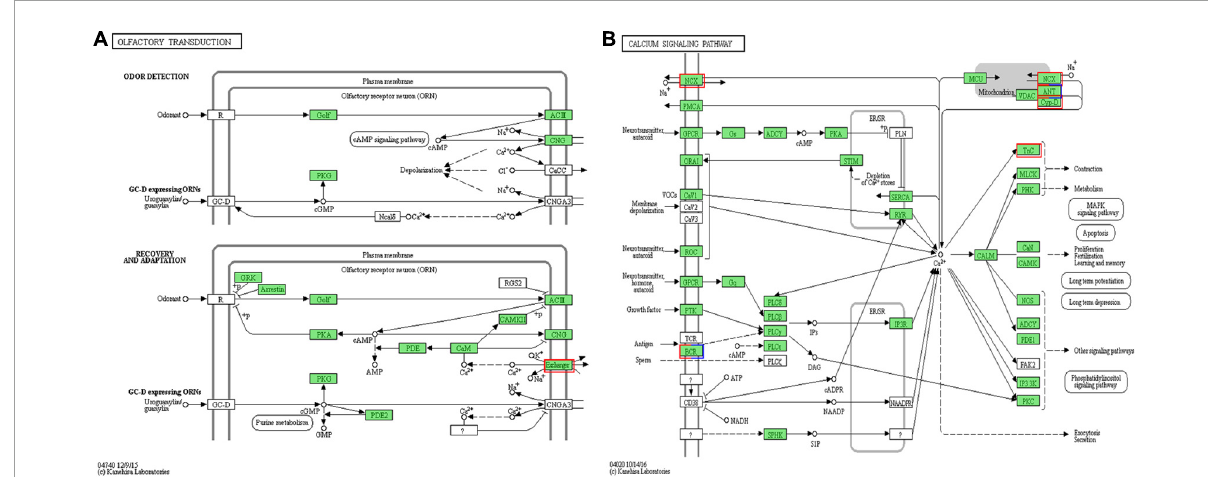
FIGURE3 The calcium-related differentially expressed unigenes (DEGs) were enriched in (A) the olfactory transduction pathway and (B) the calcium signaling pathway. The red box represents the upregulated DEGs in mating period (MP) groups. The blue box represents the downregulated DEGs in MP groups, and the box with both red and blue represents that there are both up and downregulated DEGs in MP groups. The green box represents the genes annotated in the pathway without significant difference (Image credits: https://www.kegg.jp/pathway/map=map04740 &keyword=olfactory%20transduction and